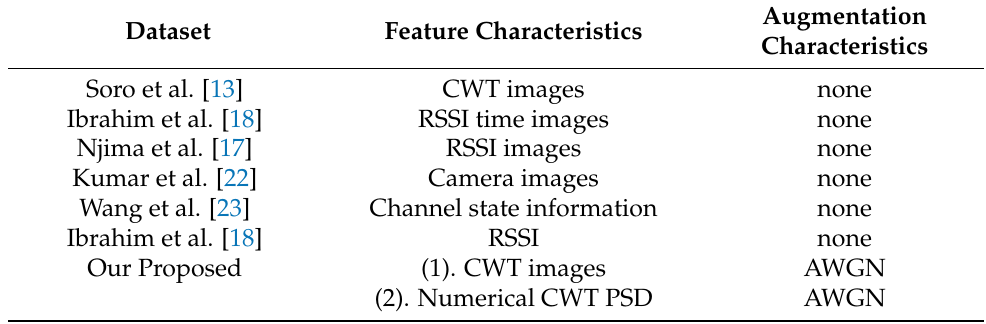
Table 1. Some existing deep learning feature set formulations used in indoor localization